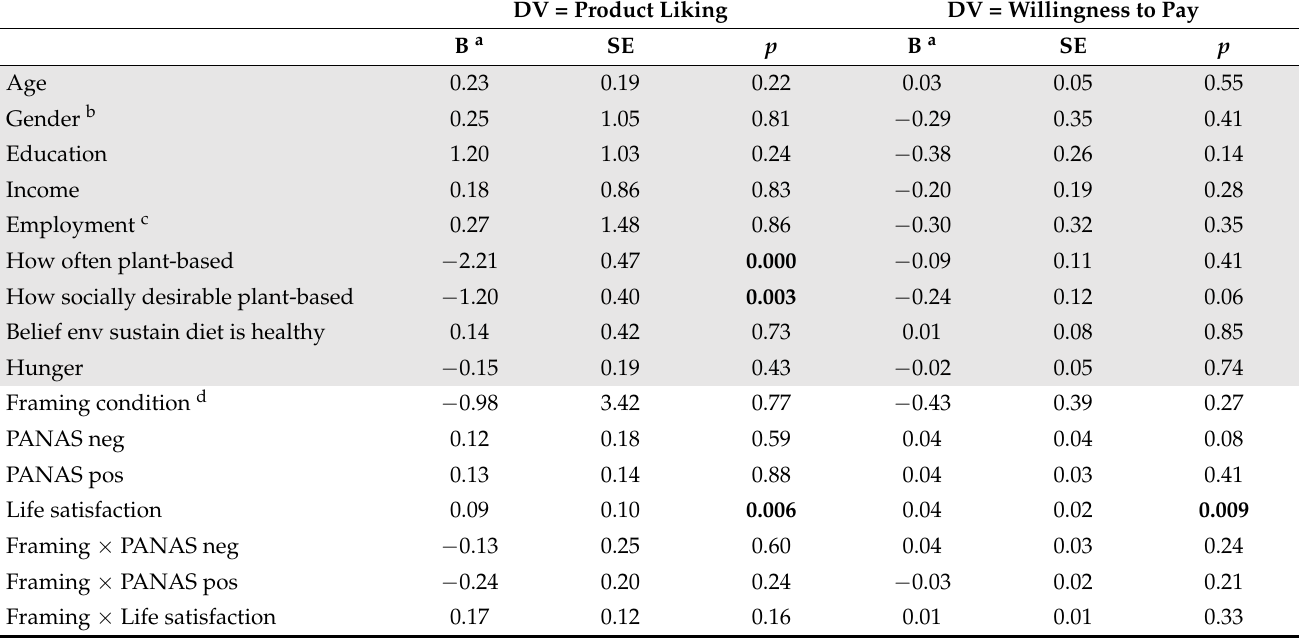
Table 1. Predictors of participants’ levels of product liking and willingness to pay in Study 1. DV = Product Liking DV = Willingness to